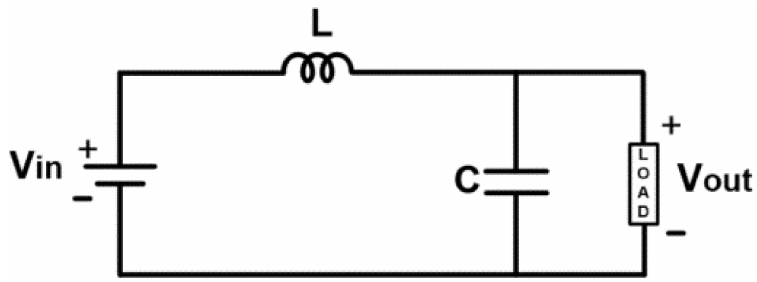
Figure 4. Equivalent circuit in its simplest